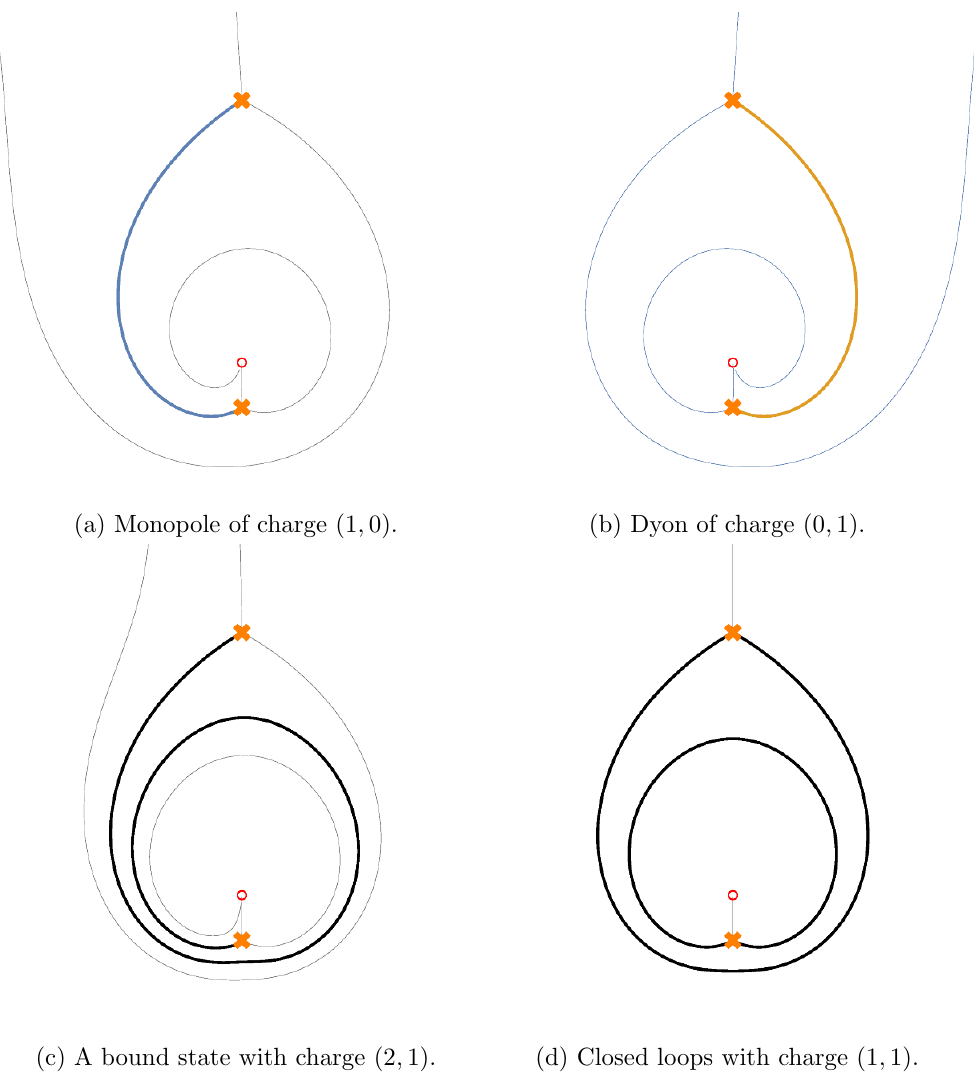
(c) A bound state with charge (2 ; 1). (d) Closed loops with charge (1 ; 1). Figure 4. Finite webs in the pure SU(2) gauge theory at u = 2 i